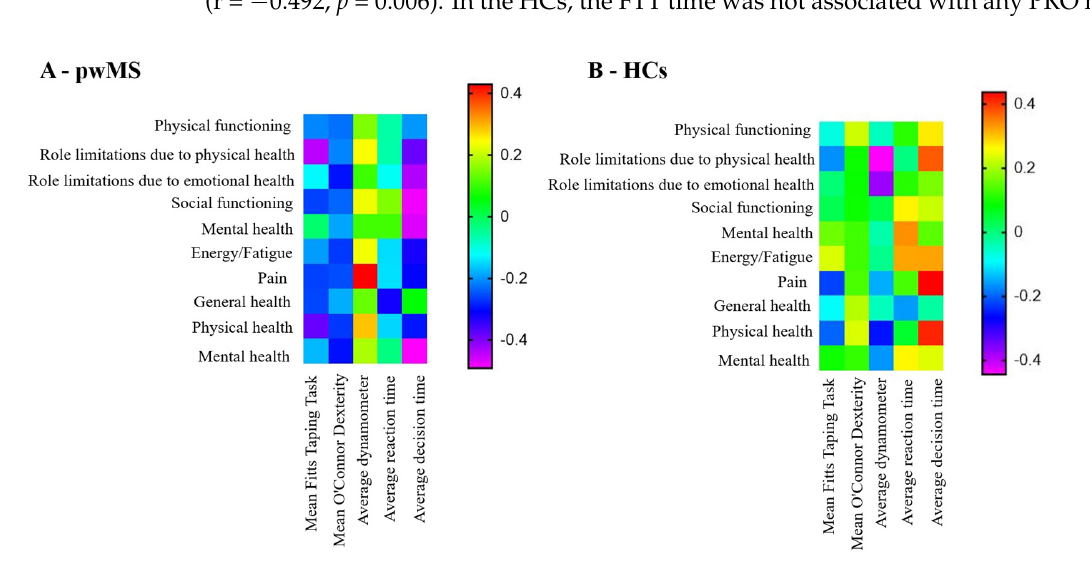
Figure 5. Correlation matrix between psychomotor performance and PROs in pwMS and HCs. Leg ‐ end: pwMS − people with multiple sclerosis, HCs − healthy controls, PROs − patient ‐ reported out ‐ comes. The correlation matrix depicts the correlation coefficients (r) derived from Pearson’s corre ‐ lations. ( A ) − correlations between psychomotor performance and PROs in people with multiple scle ‐ rosis, ( B ) − correlations between psychomotor performance and PROs in healthy controls.